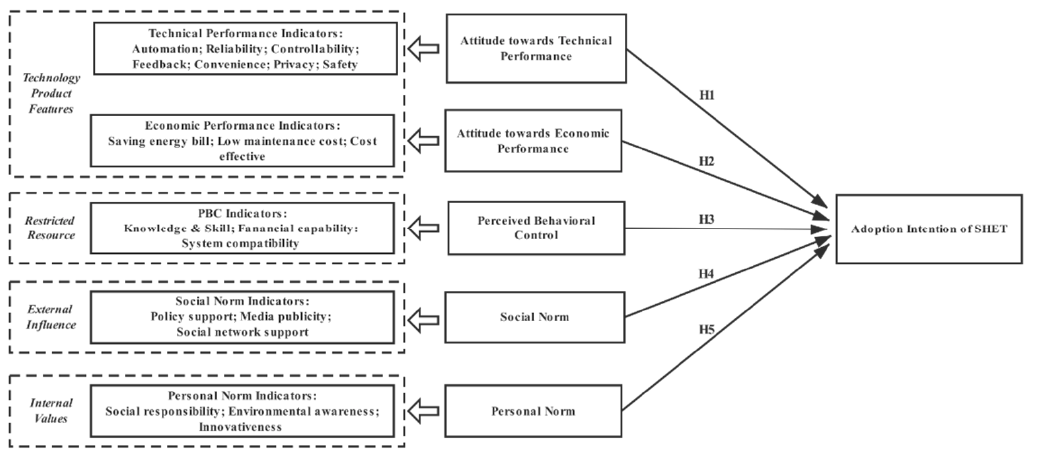
Figure 2. Theoretical research model describing the intention to adopt SHET .